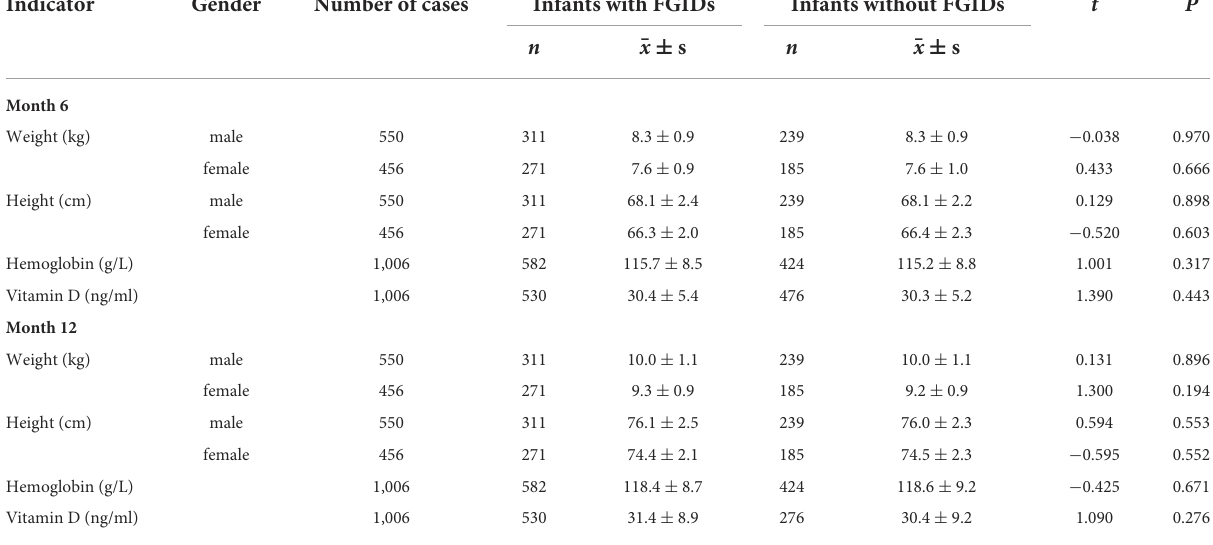
TABLE 5 Comparison of the weight, height, hemoglobin level, and vitamin D levels of infants at month 6 and month 12.